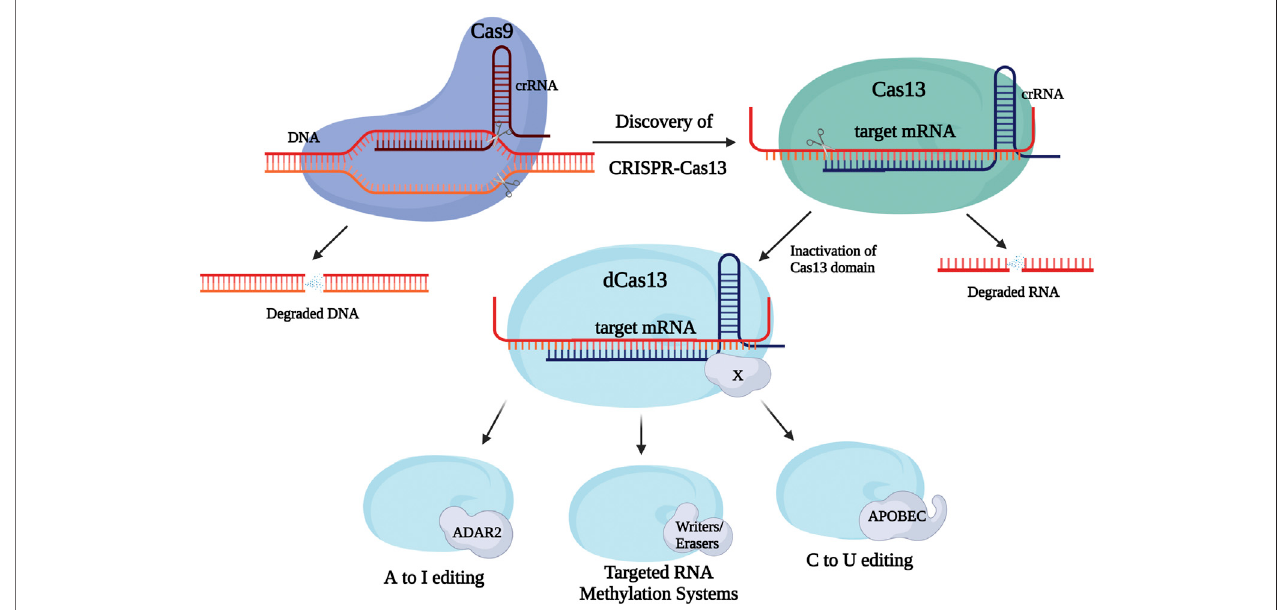
FIGURE 1 | Discovery and development of Clustered Regularly Interspaced Short Palindromic Repeats (CRISPR)/Cas systems for epitranscriptome editing. CRISPR-Cas9 is established as a tool capable of DNA targeting and modi fi cation, however, the rising implementation of RNA editing strategies led to the discovery of a natural RNA-targeting CRISPR system, Cas13. In turn, further modi fi cation of members of the Cas13 family in addition to fusions with different enzyme domains (e.g., writers, erasers) allows for performance of a variety of functions/modi fi cations upon binding to its